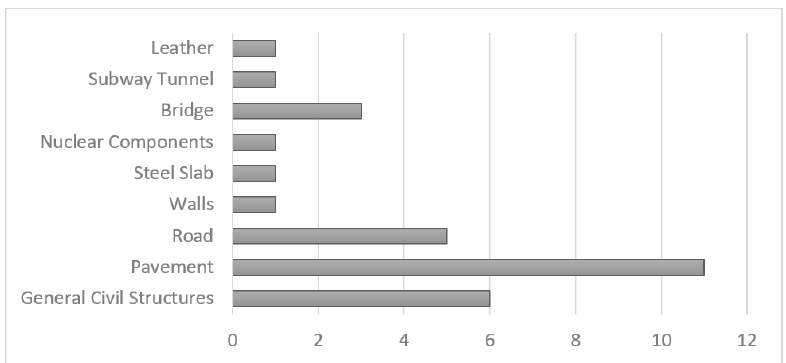
Figure 9. The domain of the Crack Detection Techniques.